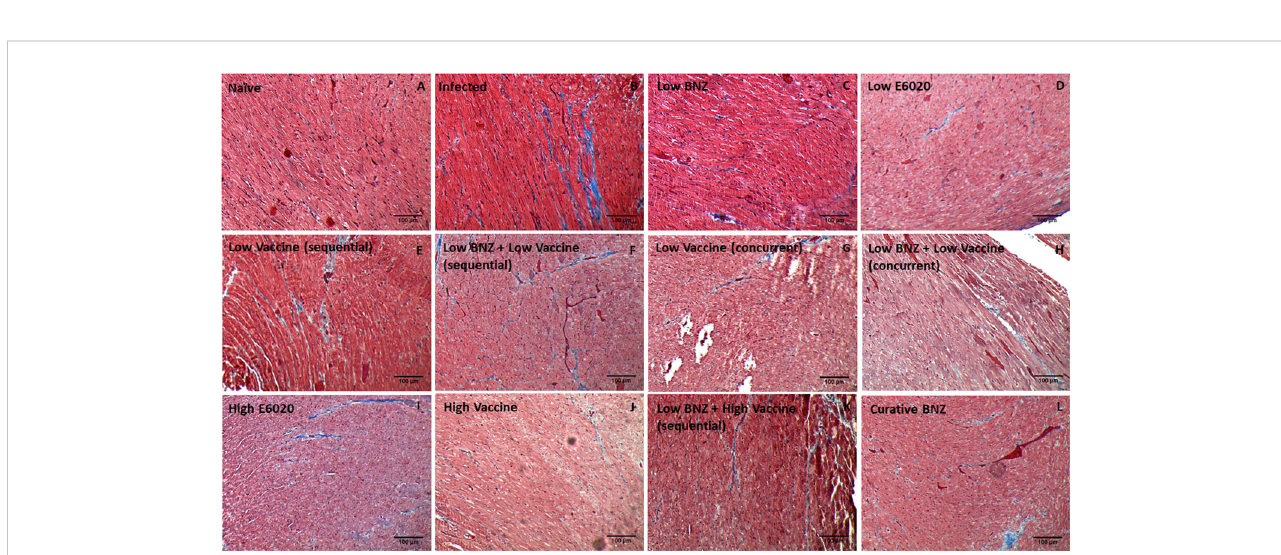
FIGURE 11 Representative images of Masson ’ s Trichrome stained cardiac tissue sections from naïve (A) , infected untreated (B) and treated (C – L) mice. Images were captured at 100X magni fi cation. Scale bar represents 100µm.